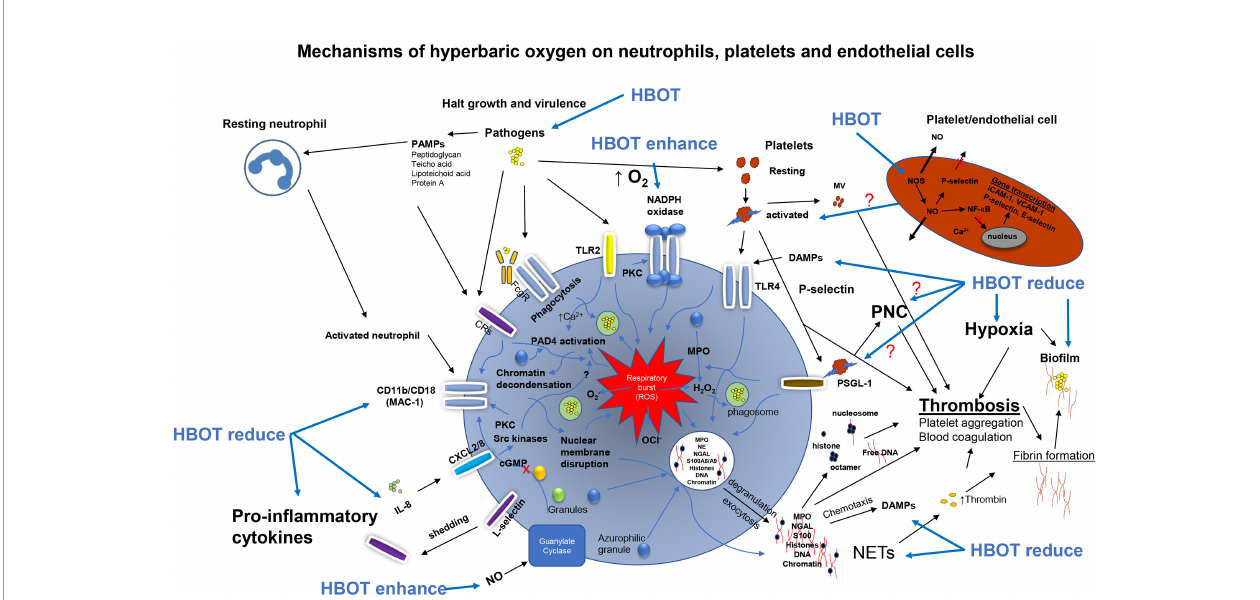
FIGURE 2 | Overview of the activations pathways of neutrophils, platelets and endothelial cells promoted by pathogens and the possible effects of hyperbaric oxygen treatment (HBOT). Pathogens activates the NADPH oxidase driving the respiratory burst when phagocytized. Pathogens directly activates toll-like receptor 2 (TLR2 or TLR4) and complement receptors (CRs) enhancing the respiratory burst generating reactive oxygen species e.g. hydrogen peroxide (H 2 O 2 ), superoxide (O 2 - ) and hypochlorite (OCl - ) for bacterial killing of phagocytosed bacteria. On the cell wall of bacteria are several pathogen-associated molecular patterns (PAMPs) which are pathogen derived alerting the host response. Host derived damage-associated molecular pattern (DAMPs) also alert the host response enhancing chemotactic signaling. The activated neutrophil upregulates the expression B 2 integrin CD11b/CD18 (MAC-1) and integrin L-selectin released (shedding) by increased expression of CD11b/CD18. Platelets are directly activated by S. aureus and activated platelets bind toll-like receptor 4 (TLR4) stimulating ROS. Activated platelets expressing P-selectin bind to the ligand PSGL-1 forming neutrophil-platelets complexes (PNC) enhancing the respiratory burst system. Activated platelets and lysed platelets release platelet microvesicles (MV) in circulation activating the intrinsic pathway (contact pathway) of the coagulation cascade leading to increased thrombin. Excessive platelet binding of the PMN triggers neutrophil extracellular traps (NET) release and hyperactivation of the ROS system transporting granules to the membrane by exocytosis and NETosis (membrane disruption), exact mechanism unknown. Antimicrobial peptides are released (e.g. myeloperoxidase (MPO), neutrophil elastase (NE), neutrophil gelatinase-associated lipocalin (NGAL), S100A8/A9) to the extracellular space. Besides antimicrobial components NETs consist of chromatin, DNA and histone facilitating thrombosis and thrombin generation. Activation of NADPH oxidase results in the activation of protein-arginine deiminase 4 (PAD4) converting arginine to citrulline on histones and chromatin decondensation in the nucleus of the PMN. NE and MPO are release for granules (azurophilic) in the cytosol facilitating H 2 O 2 and unfolding of chromatin. Interleukin 8 (IL-8) bind CXCL2/8 increasing CD11b/CD18 by activation of pathways (protein kinase C, PKC) and Src kinases) inducing NET release. Collectively, these activation pathways are believed to be halted by HBOT resulting in reduced collateral tissue damage in severe infections as infective endocarditis. NADPH, Nicotinamide Adenine Dinucleotide Phosphate; Protein Kinase A; ROS, Reactive Oxygen